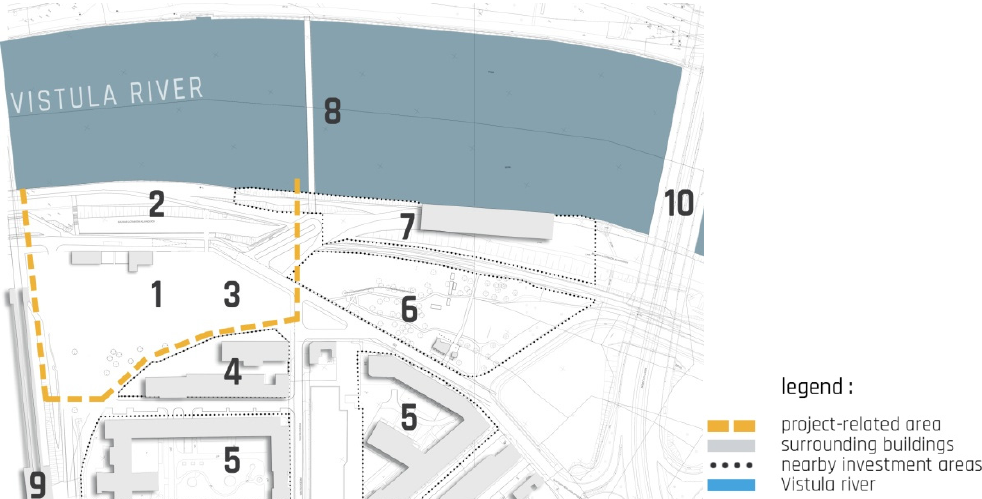
Figure 4. Potentially important places in the vicinity of the project-related area: (1) Project-related area; (2) Boulevard of the Allied Forces Pilots (Bulwar Lotników Alianckich); (3) Planned memorial of the Allied Forces Pilots; (4) The project-related area borders with a lighting company; (5) New residential quarters ATAL Residence and Garden Residence; (6) Park “Vistula Station” (“Park Stacja Wisła”) which gained an award in the contest for the best developed space in Poland; (7) Planned Cracow Marina (“Marina Kraków”); (8) Planned flyover for pedestrians and bicycles; (9) Railway station Kraków Zab ł ocie; (10) Kotlarski Bridge (Most Kotlarski) (elaborated by E. Latusek).